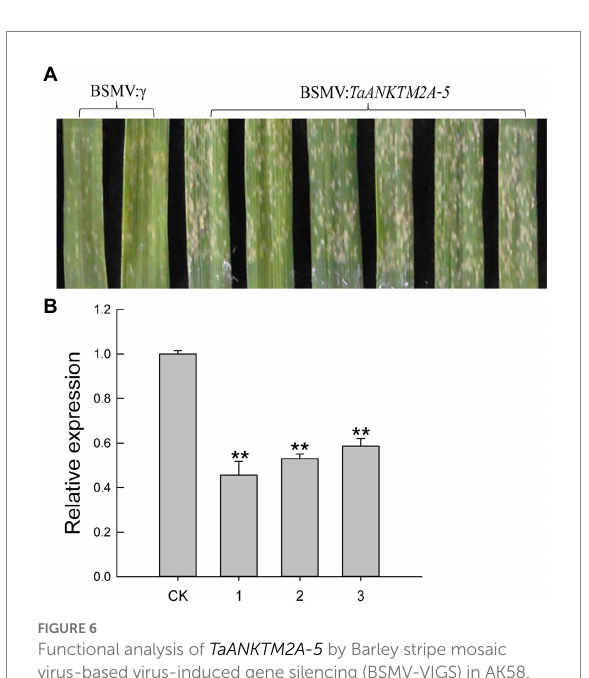
FIGURE 6 Functional analysis of TaANKTM2A-5 by Barley stripe mosaic virus-based virus-induced gene silencing (BSMV-VIGS) in AK58. (A) BSMV: TaANK2A-5 infected plants were inoculated with Blumeria graminis f. sp. Tritici , and their leaves were photographed 6 days post-inoculation. BSMV: γ infected plants were performed as controls. The experiment was repeated independently three times, and the same results were obtained. (B) Expression of TaANKTM2A-5 in BSMV: TaANKTM2A-5 - infected leaves was compared with that in BSMV: γ -infected controls of AK58. CK represents plants inoculated with BSMV: γ , and 1–3 represents plants inoculated with BSMV: TaANK2A-5 . Significant differences assessed using Duncan’s honestly significant difference test, ** p <